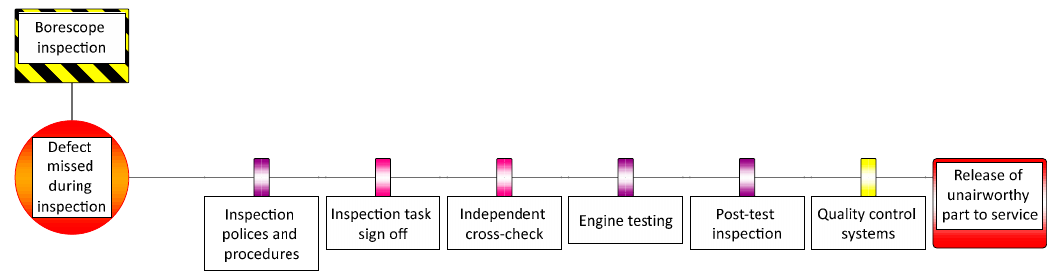
Figure 19. Consequence path with barriers.